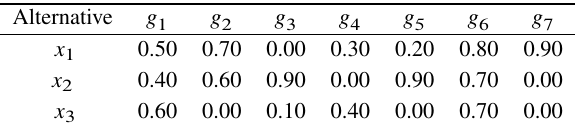
Table 5 Fuzzy soft set ( F ; I 1 ).